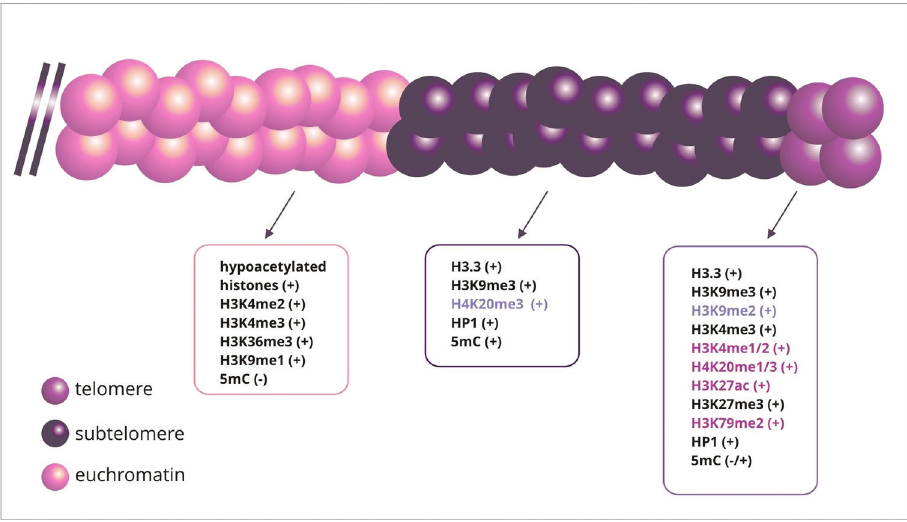
Figure 4. Epigenetic modifications in telomere and subtelomere chromatin and adjacent euchromatin. Epigenetic markers in telomere and subtelomere regions characteristic for both plants and animals are marked with black color, only for plants with violet colour, only for animals with rose